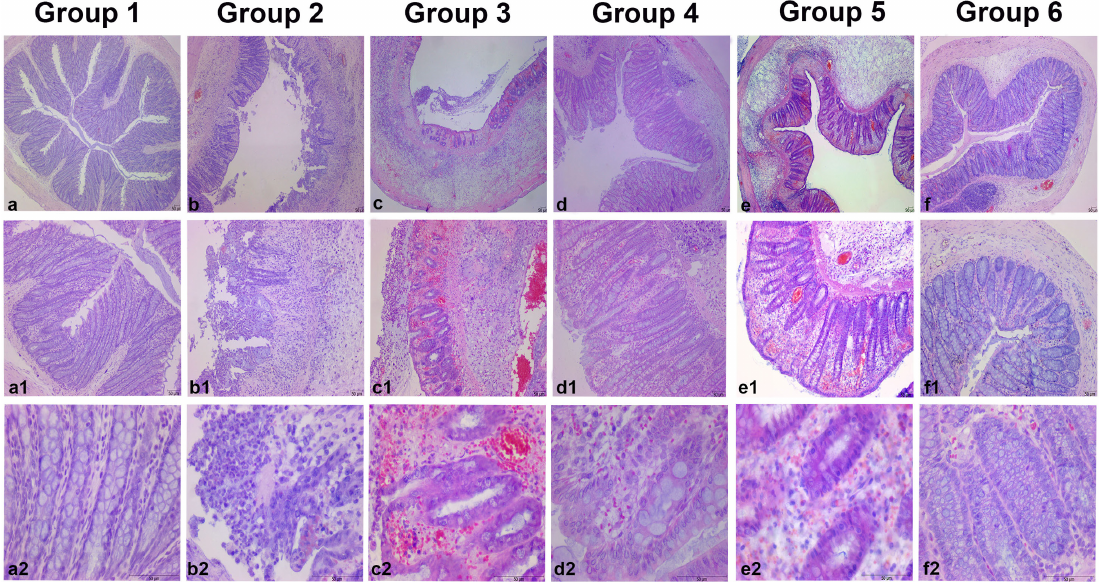
Figure 1. Hematoxylin and eosin staining of colon descendens of experimental groups’. Scale bars: 50 µm. Figures a-f 40 × , a1-f1 100 × , a2-f2 400 ×